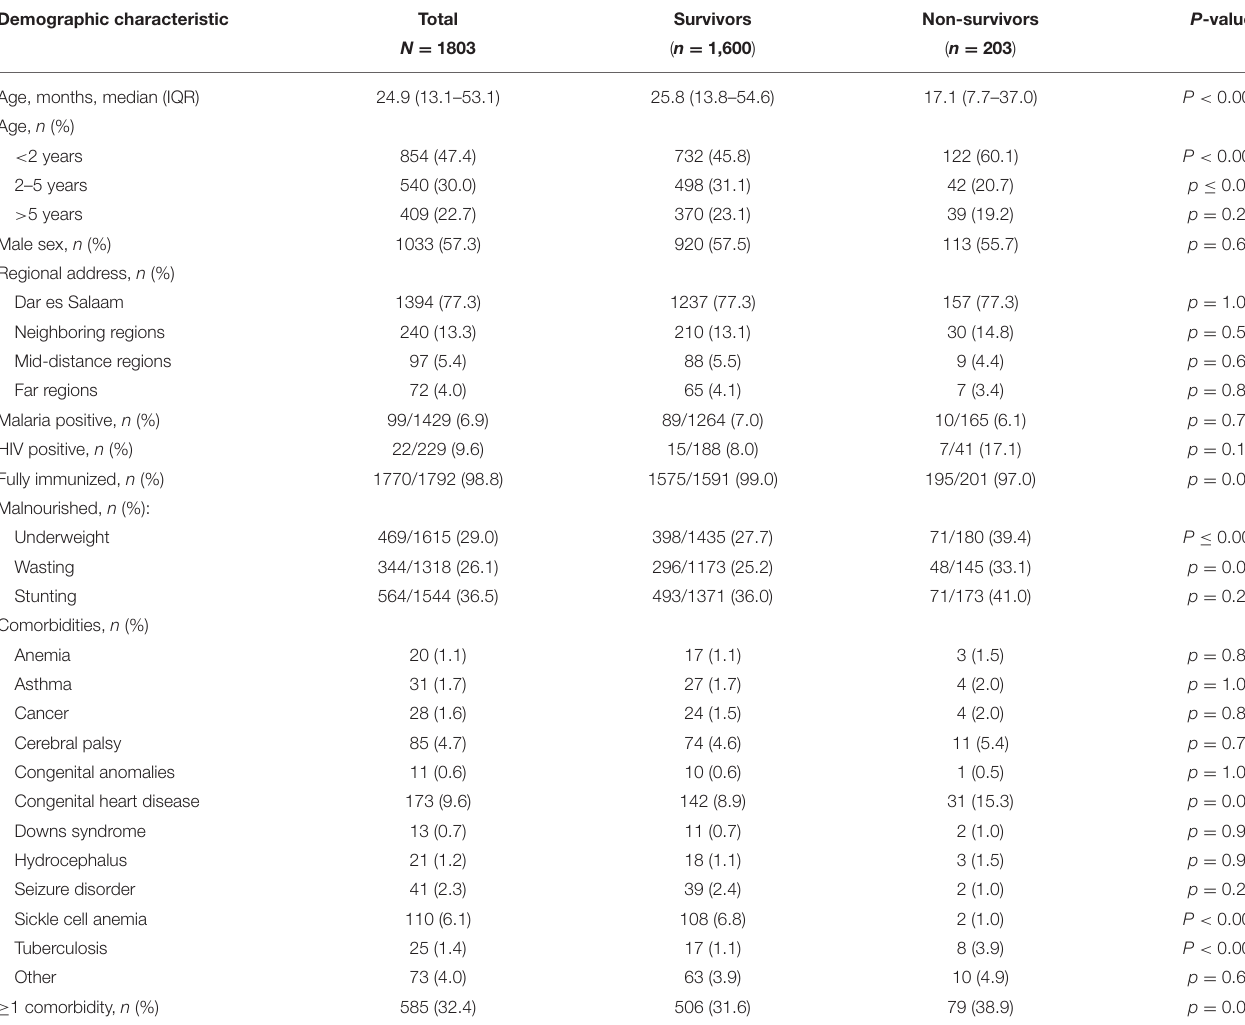
TABLE 1 | Descriptive statistics for the full cohort and a comparison of demographic characteristics by mortality outcome. Demographic